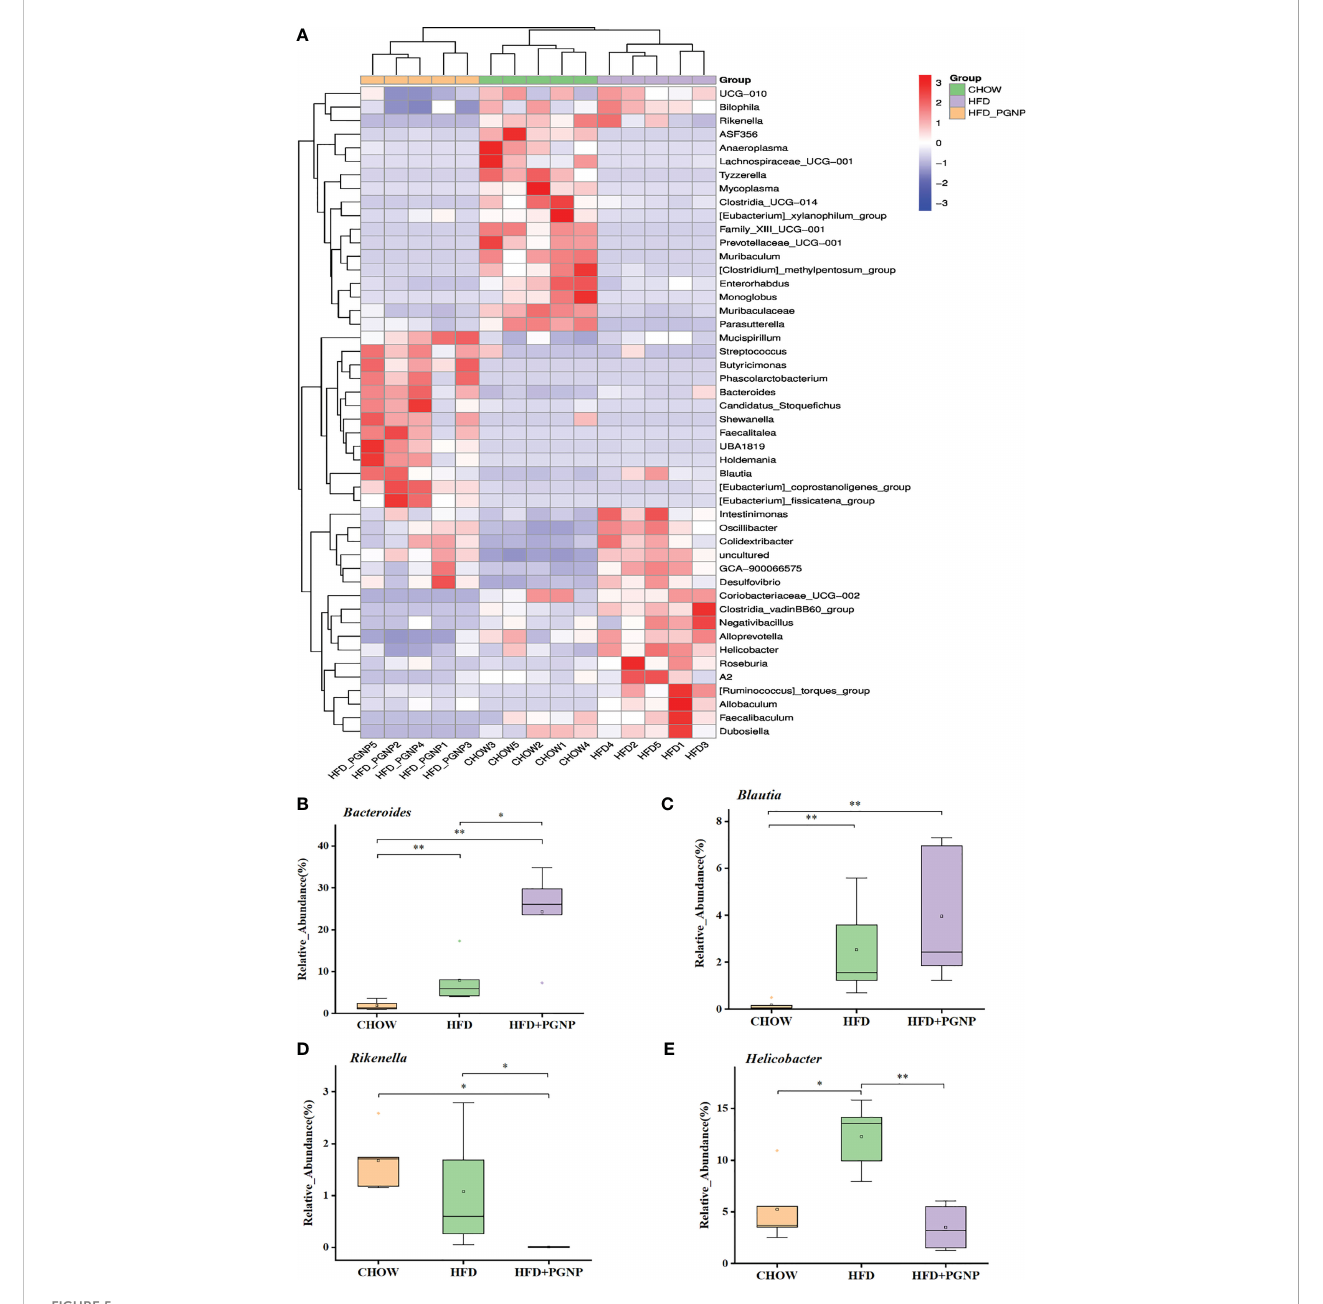
FIGURE 5 Heatmap ofmicrobial distributions at the genus level for each sample. Blocksin red andblue denote highand low z-scorevalues of OTUsizes, respectively (A) . Effects ofPGNPonthe relative abundanceof Bacteroides (B) , Bualtia (C) , Rikenella (D) , and Helicobacter (E) in HFD-fed mice. ** P < 0.01, * P <